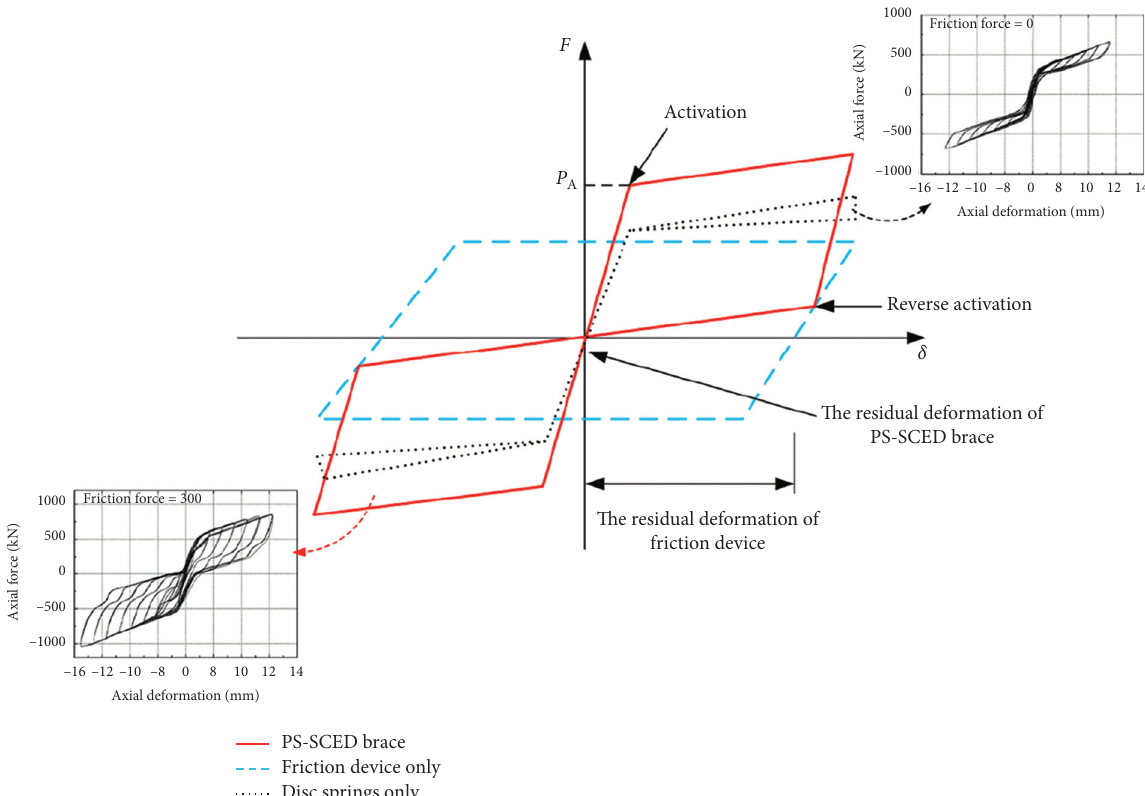
Figure 18: Hysteretic response of PS-SCED brace (adapted from